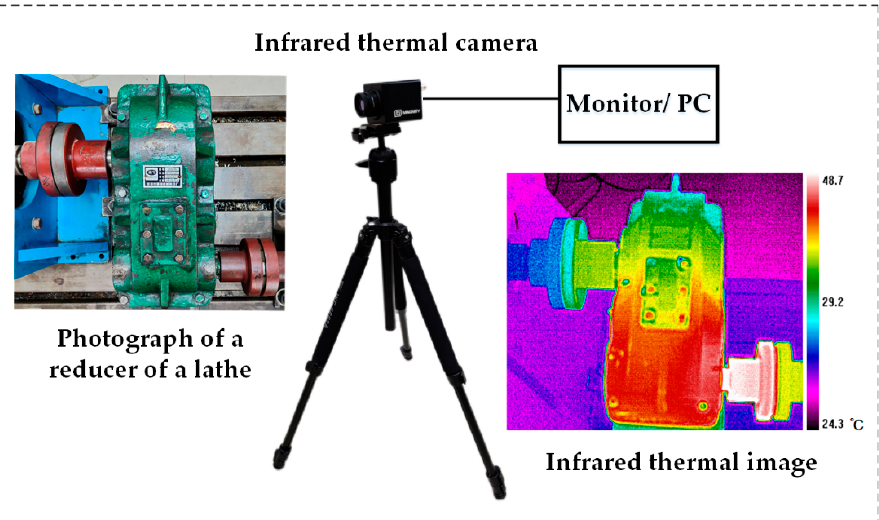
Figure 6. The schematic diagram of IRT experimental device.